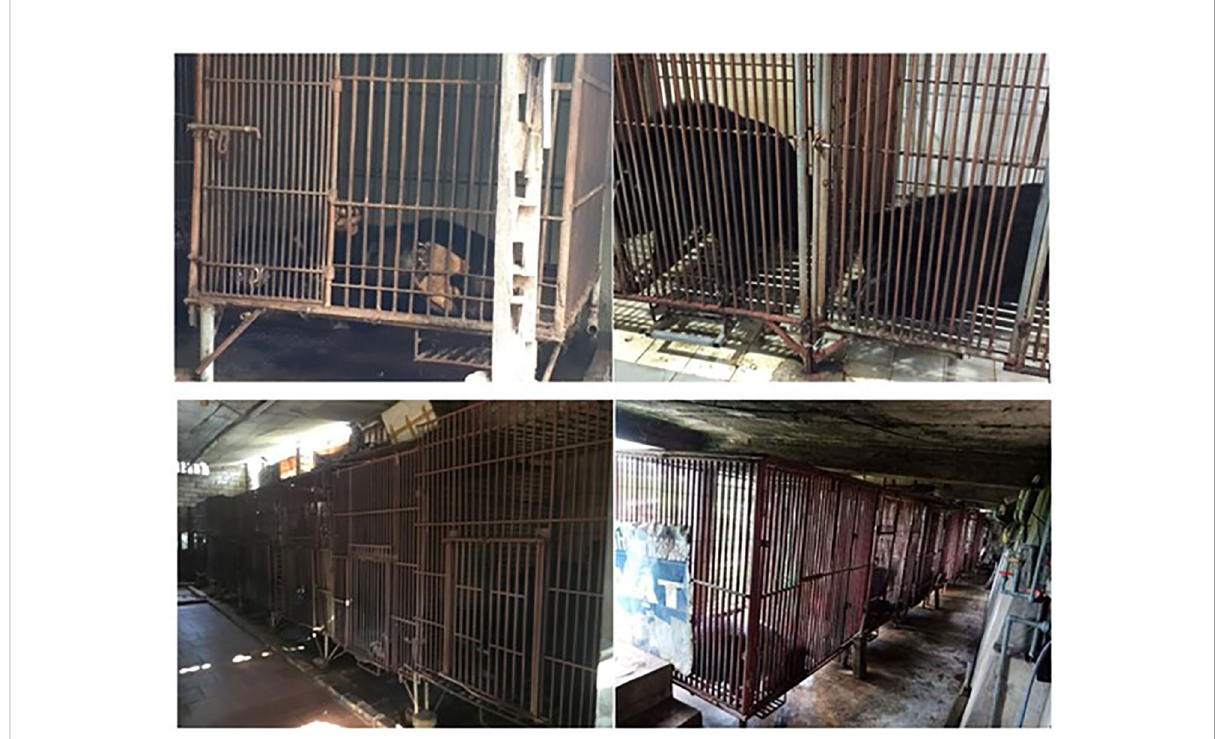
FIGURE 2 Images showing examples of bear farm enclosures across Vietnam: (top left) bear enclosures on a small farm in central Vietnam, (top right) a small farm in the south of Vietnam, (bottom left) a large farm in the north of Vietnam and (bottom right) a large farm in central